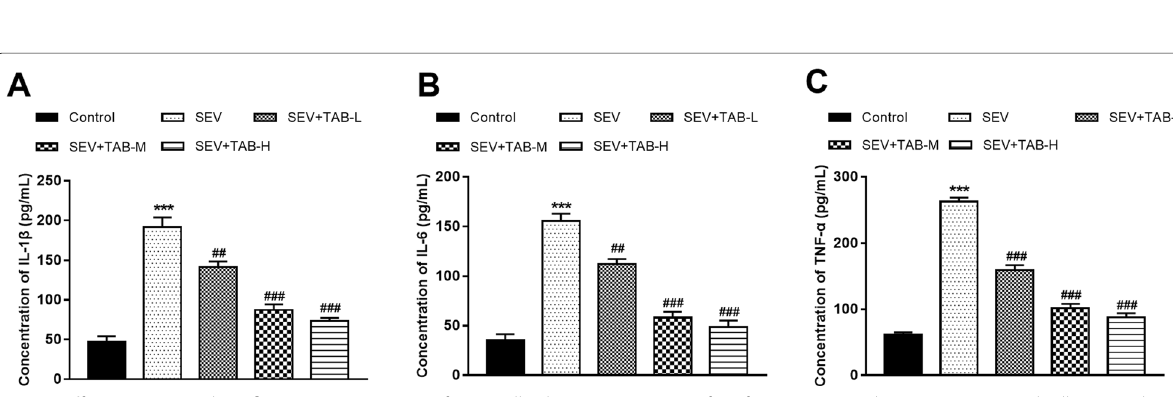
Fig. 3 Effects on TAB on the inflammatory responses of HAPI cells. The concentrations of IL-1β ( A ), IL-6 ( B ) and TNF-α ( C ) were markedly upregulated by sevoflurane, but were significant inhibited by TAB treatment. *** P < 0.001 compared to normal group; ## P < 0.01, ### P < 0.001 compared to SEV